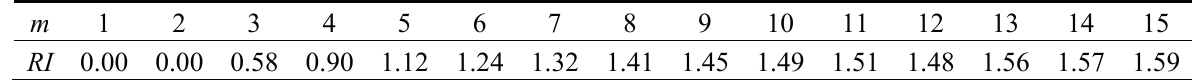
Table 7. Random index (RI) of random